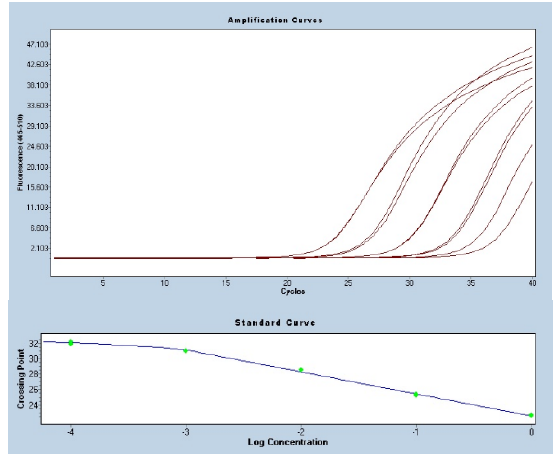
Figure 2. Amplification curves and standard curve obtained for a series of 10-fold dilutions of the cDNA for the UB gene. The RT-qPCR reaction used to generate curves was performed in a LightCycler480 (Roche) thermal cycler in two technical replications for one randomly selected sample, with SYBR Green as the intercalating dye.